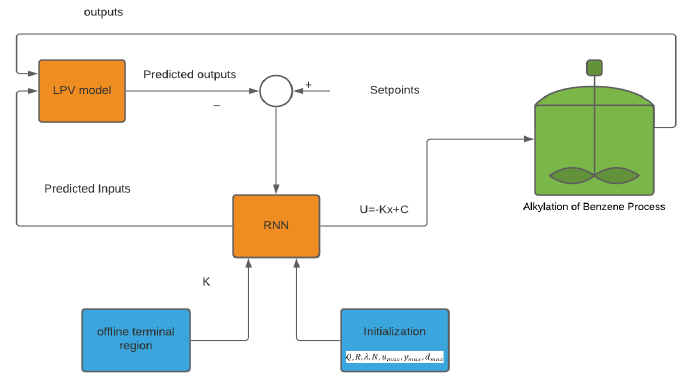
Figure 1. Recurrent neural network (RNN) framework [31].